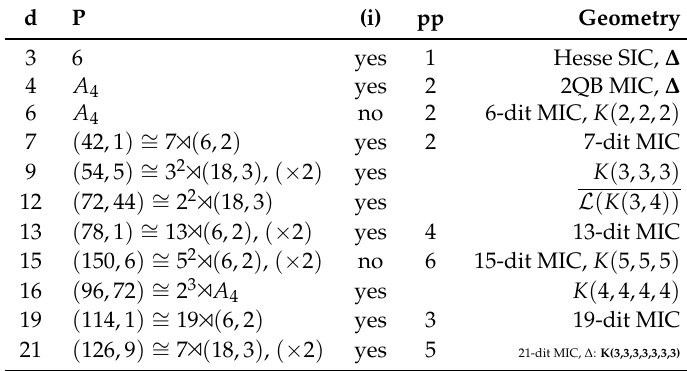
Table 2. Table of 3-manifolds M 3 found from subgroups of finite index d of the fundamental group π 1 ( S 3 \ K 4 a 1) (alias the d -fold cov- erings over the figure-eight knot 3-manifold). The covering type ‘ty’ in column 2, the manifold identification ‘ M 3 ’ in column 3 and the number of cusps ‘cp’ in column 4 are from SnapPy [19]. For d = 9 and 10, SnapPy does not provide results so that we only identify the permuta- tion group P =SmallGroup( o, k ) (abbreviated as ( o, k )), where o is the order and k is the k -th group of order o in the standard notation (that is used in Magma). If it exists, the MIC is ‘ pp ’-valued. If (i) is true, unless otherwise specified, the graph of cosets leading to a MIC is that of the d -simplex [and/or the condition (ii) is true: no geometry]. The symbol ∆ means that (ii) fails to be satisfied. When there exists a MIC with (i) true and (ii) false, the geometry is shown in bold characters. The symbol ‘fd’ means a false detection of a MIC when (i) and (ii) are satisfied simultaneously while a MIC does not exist. The abbreviations ‘Fano’, ‘ d -ortho’ and ‘[10 3 ]’ are for the Fano plane, the d -orthoplex and the corresponding geometric configuration. 3. MIC states pertaining to the Trefoil knot and its 0 -surgery We now investigate the relation of MIC states to the group geometrical axioms (i)-(ii) (or their negation) in the context of the trefoil knot 3 1 (in Sec. 3.2) and